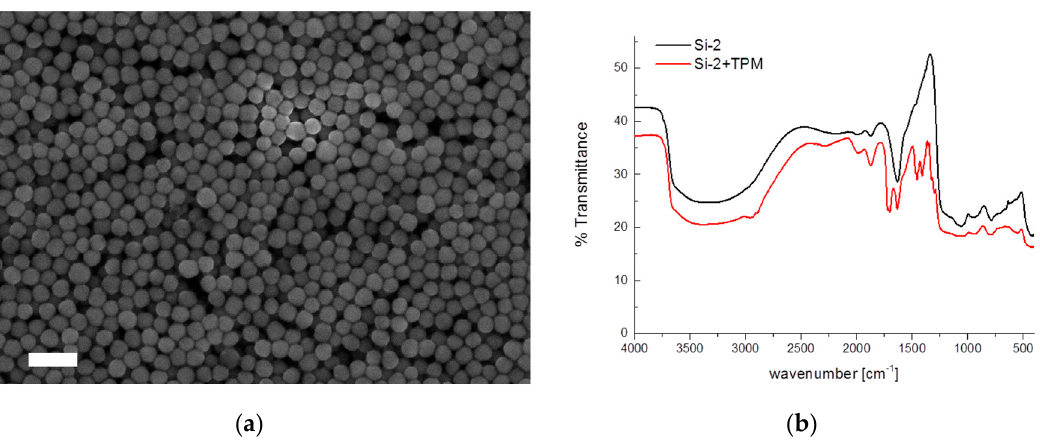
Figure 1. ( a ) Scanning electron microscopy (SEM) image of silica particles (Si-2). The scale bar is 200 nm; ( b ) Fourier transformed infrared spectroscopy (FTIR) spectra of Si-2 before and after (Si-2+TPM) surface modification with TPM.